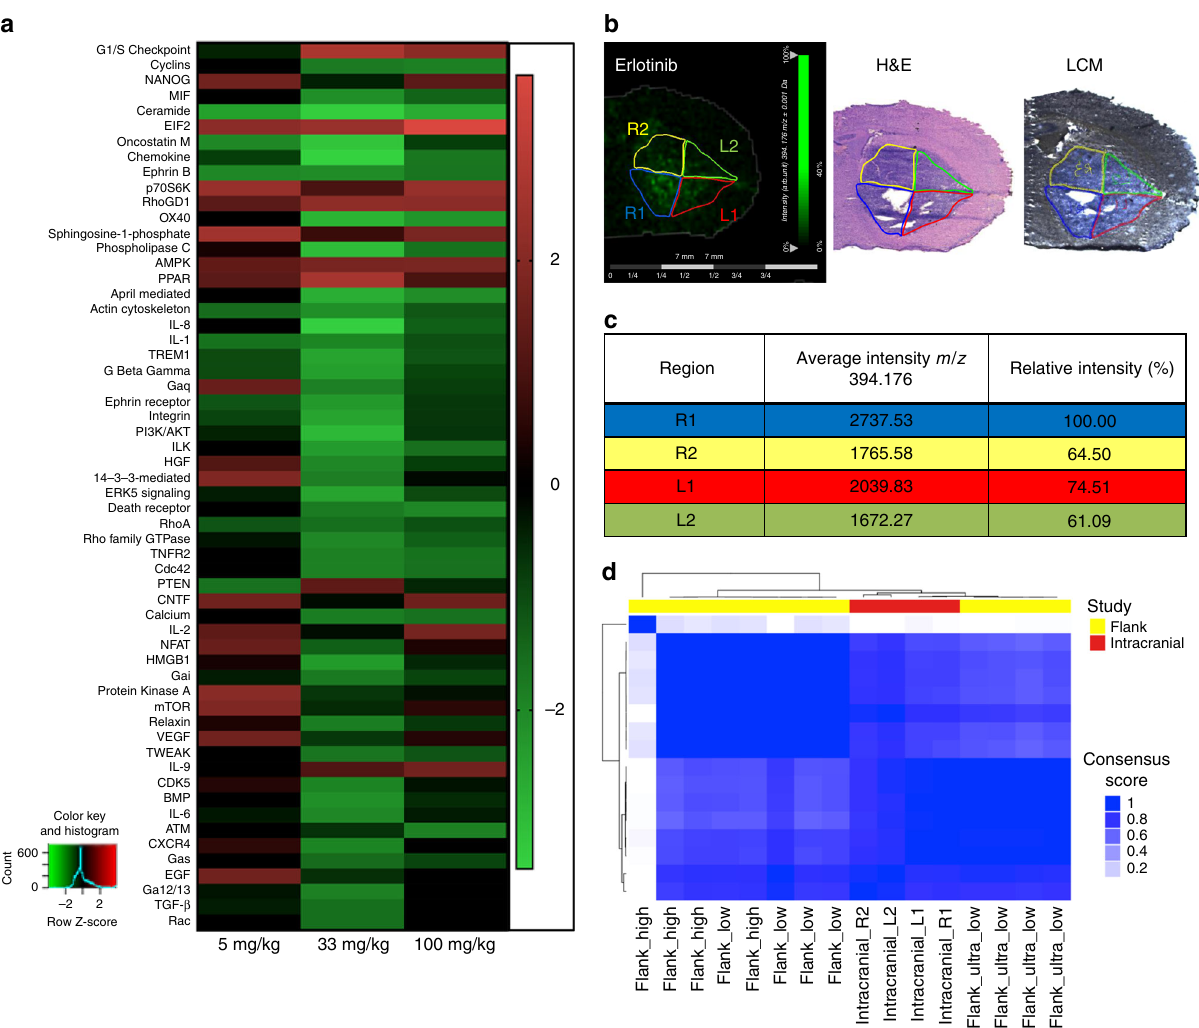
Fig. 6 mRNA sequencing of fl ank and intracranial (IC) tumor tissues from animals dosed with erlotinib showing dose-dependent pathway regulation. a Summary of pathways regulated by different doses of erlotinib in fl ank tumors ( n = 5), z -Scores of signi fi cant pathways relative to placebo are presented. b MALDI MS images of erlotinib in brain tissue with IC tumor and regions of interest (R1, R2, L1 and L2) used for laser capture microdissection (LCM) and subsequent mRNA sequencing, adjacent section with H&E staining and optical image of adjacent section used for LCM. c Average (mean) relative intensity of erlotinib ( m/z 394.176) detected in each ROI of MALDI MS ion image. d Clustermap of transcripts from fl ank and IC tumors by mRNA